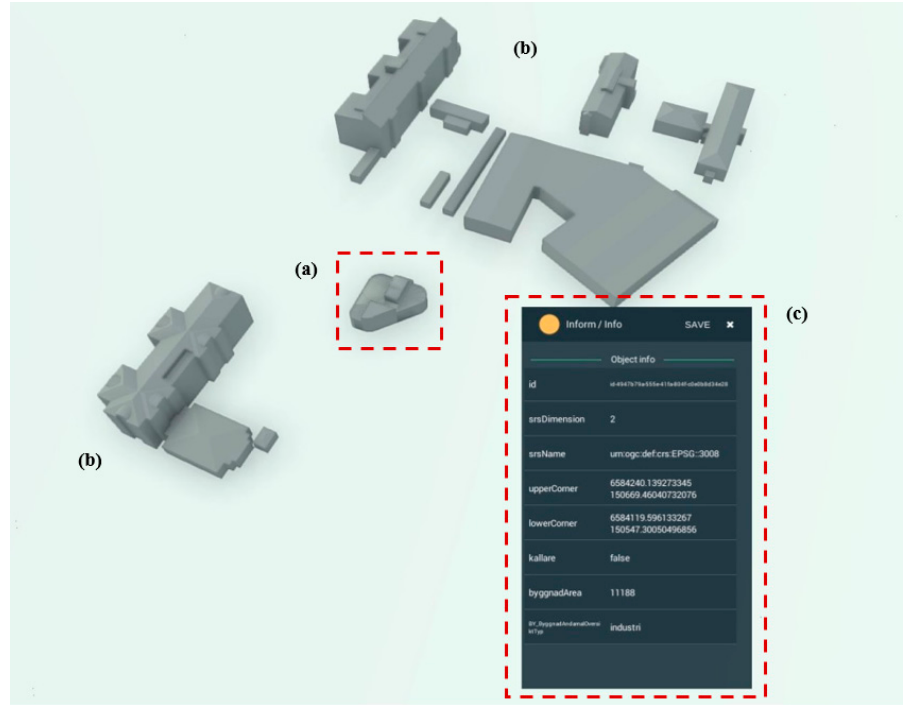
Figure 14. Visualisation in S-Visualizer: (a) the Lotsen building, LotsenLOD1GML , (b) the surrounding existing buildings, ExistingBuGML , (c) the corresponding CityGML Sve-Test attributes of building (a).